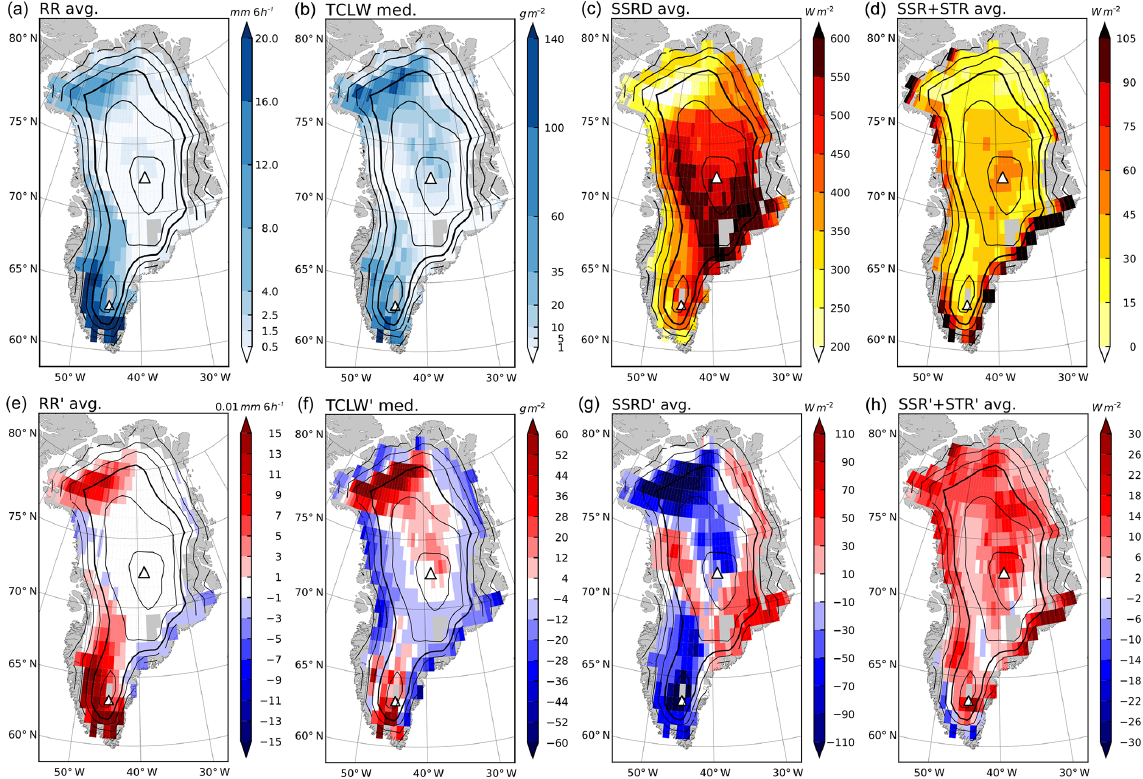
Figure 7. Composites of (a) rainfall (RR), (b) total column liquid water (TCLW), (c) surface shortwave downward radiation (SSRD), (d) net surface long- and shortwave radiation (SSR + STR) during EV69 melt time steps, and (e–h) the respective anomalies with respect to climatology. Depending on the melt impact of the variable, the composite results from the average (RR, SSRD, SSR + STR) or the median